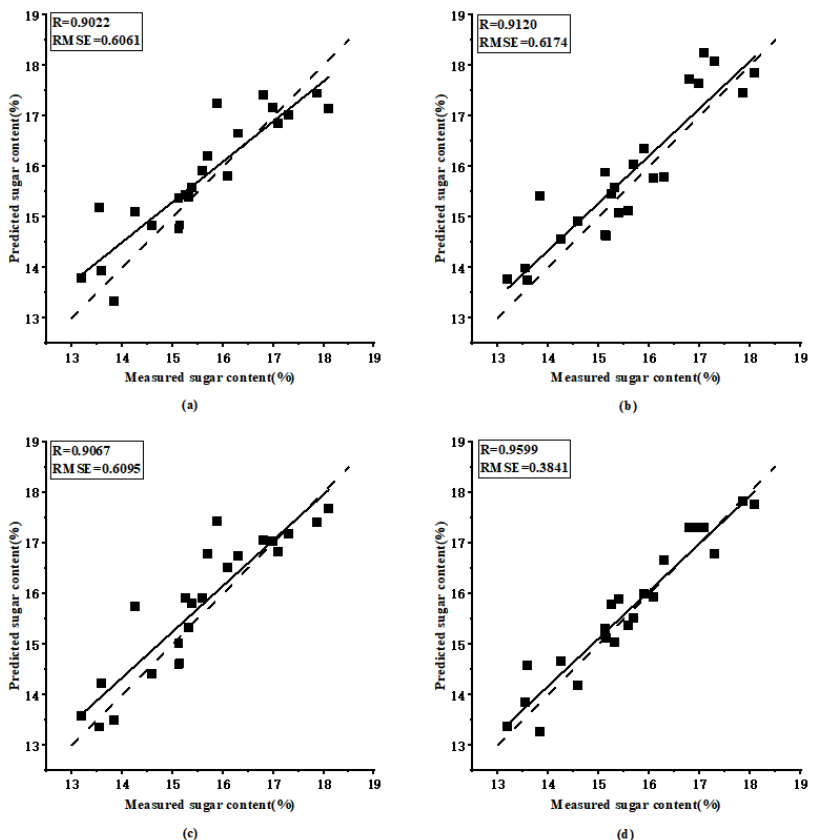
Figure 7. Performance results using FNRR-net: ( a ) prediction results based on AlexNet model with the interval of 0.4% and MSE loss function, ( b ) prediction results based on InceptionV3 model with the interval of 0.4% and MSE loss function, ( c ) prediction results based on ResNet50 model with the interval of 0.4% and MSE loss function, ( d ) prediction results based on ViT-L_16 model with the interval of 0.8% and balanced loss function. The solid line is the fitting line between the predicted and measured values, and the dotted line is 1:1 line.